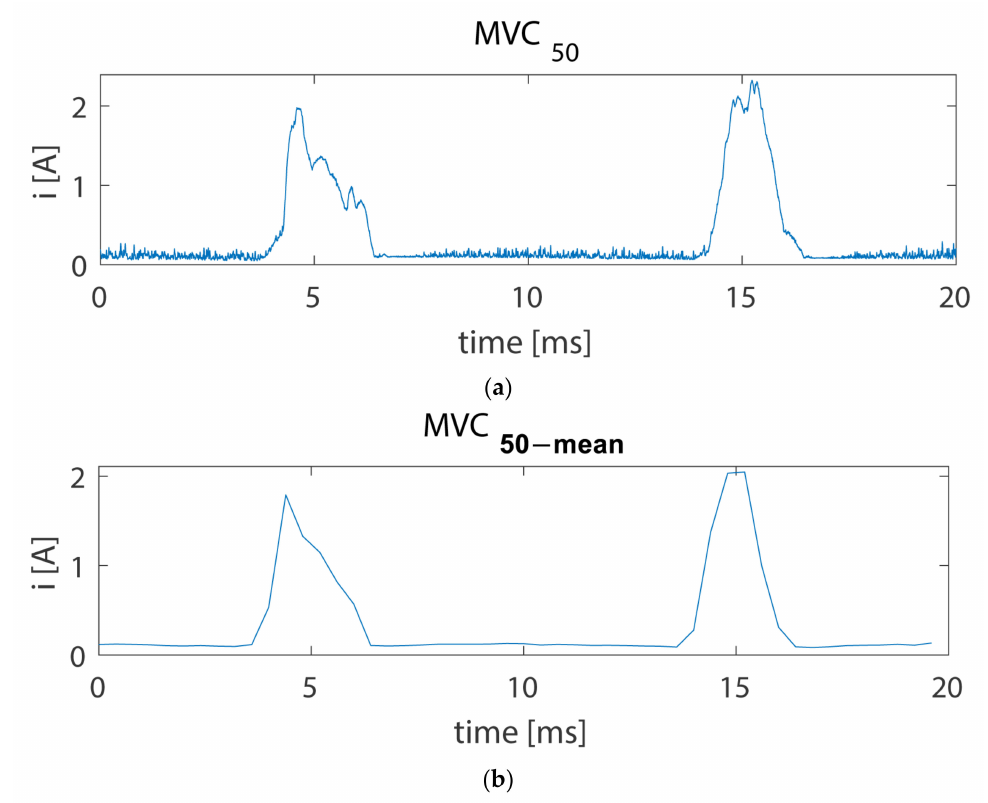
Figure 10. MVC 50 feature vector ( a ) and MVC 50 − mean ( b ) calculated for data from Figure 9.